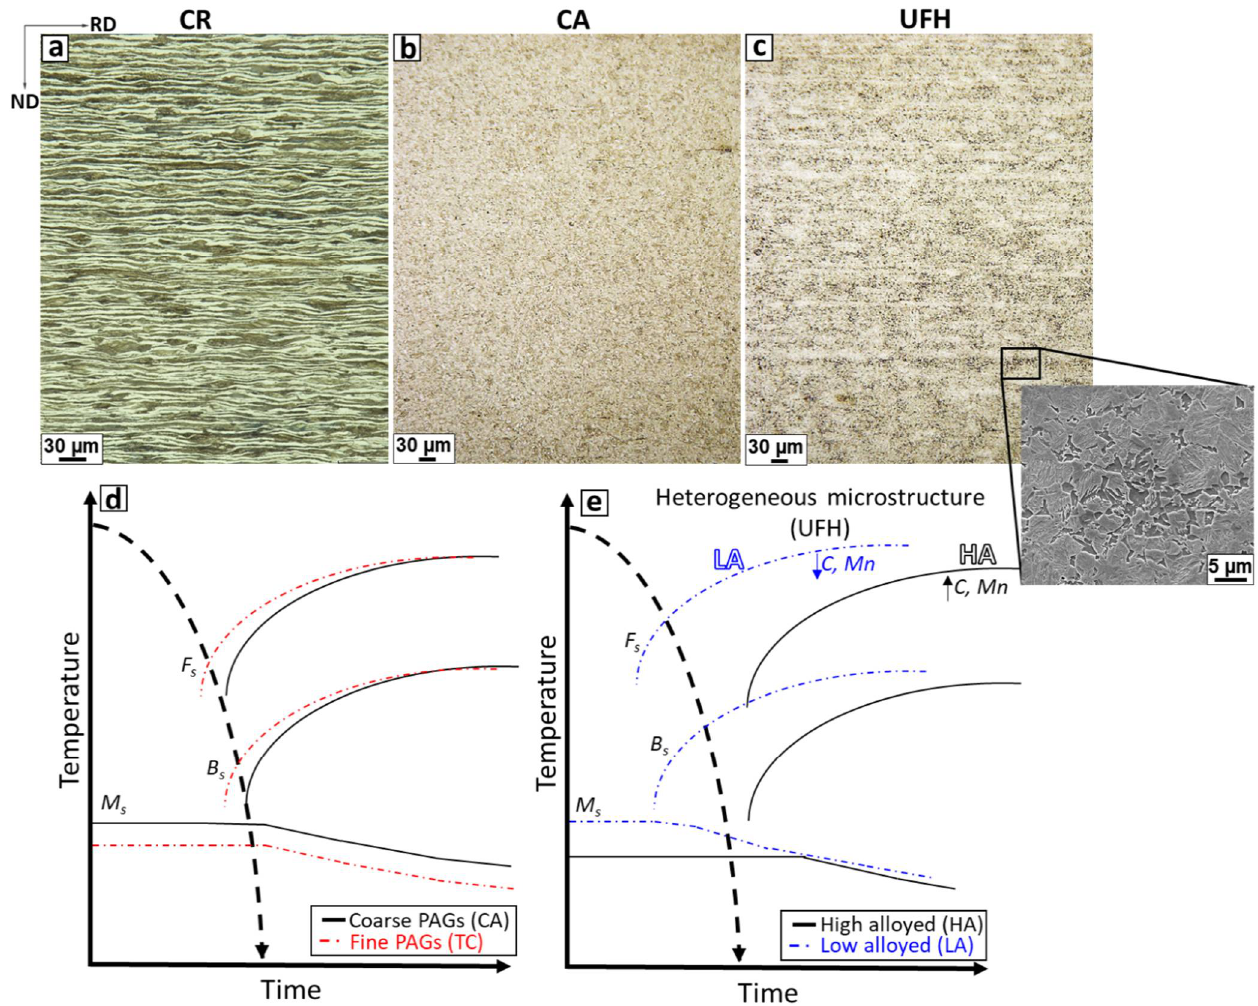
Figure 10. Optical micrographs for: ( a ) as-received material, ( b ) CA and ( c ) UFH samples. As a reference for the reader, the insert in ( c ) shows an enlarged micrograph of the heterogeneous microstructure obtained within the martensitic bands for the UFH sample. ( d ) Schematic CCT diagrams presenting the influence of the PAG size on phase transformations for CA and TC samples. ( e ) Chemical gradients in parent austenite produced via ultrafast heating annealing led to different kinetics of phase transformation (local CCT diagrams) for the UFH sample. The banded microstructure produced after UFH is inherited from the initial cold-rolled material, where LA (ferritic) and HA (pearlitic) are low alloyed and high alloyed regions, respectively.